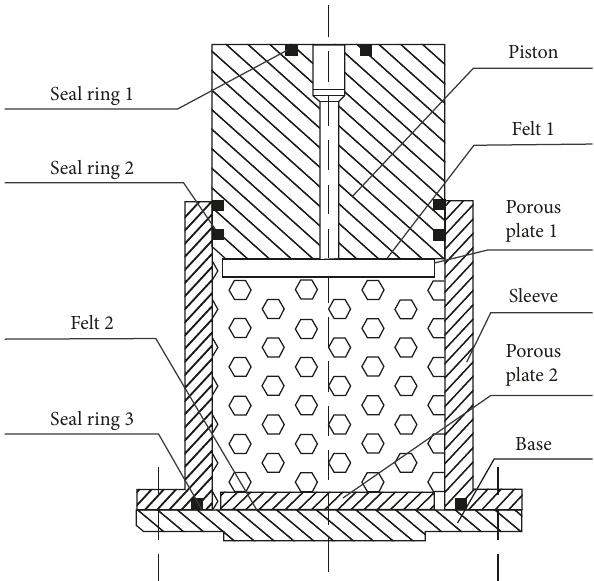
Figure 3: The permeability apparatus for compacting broken